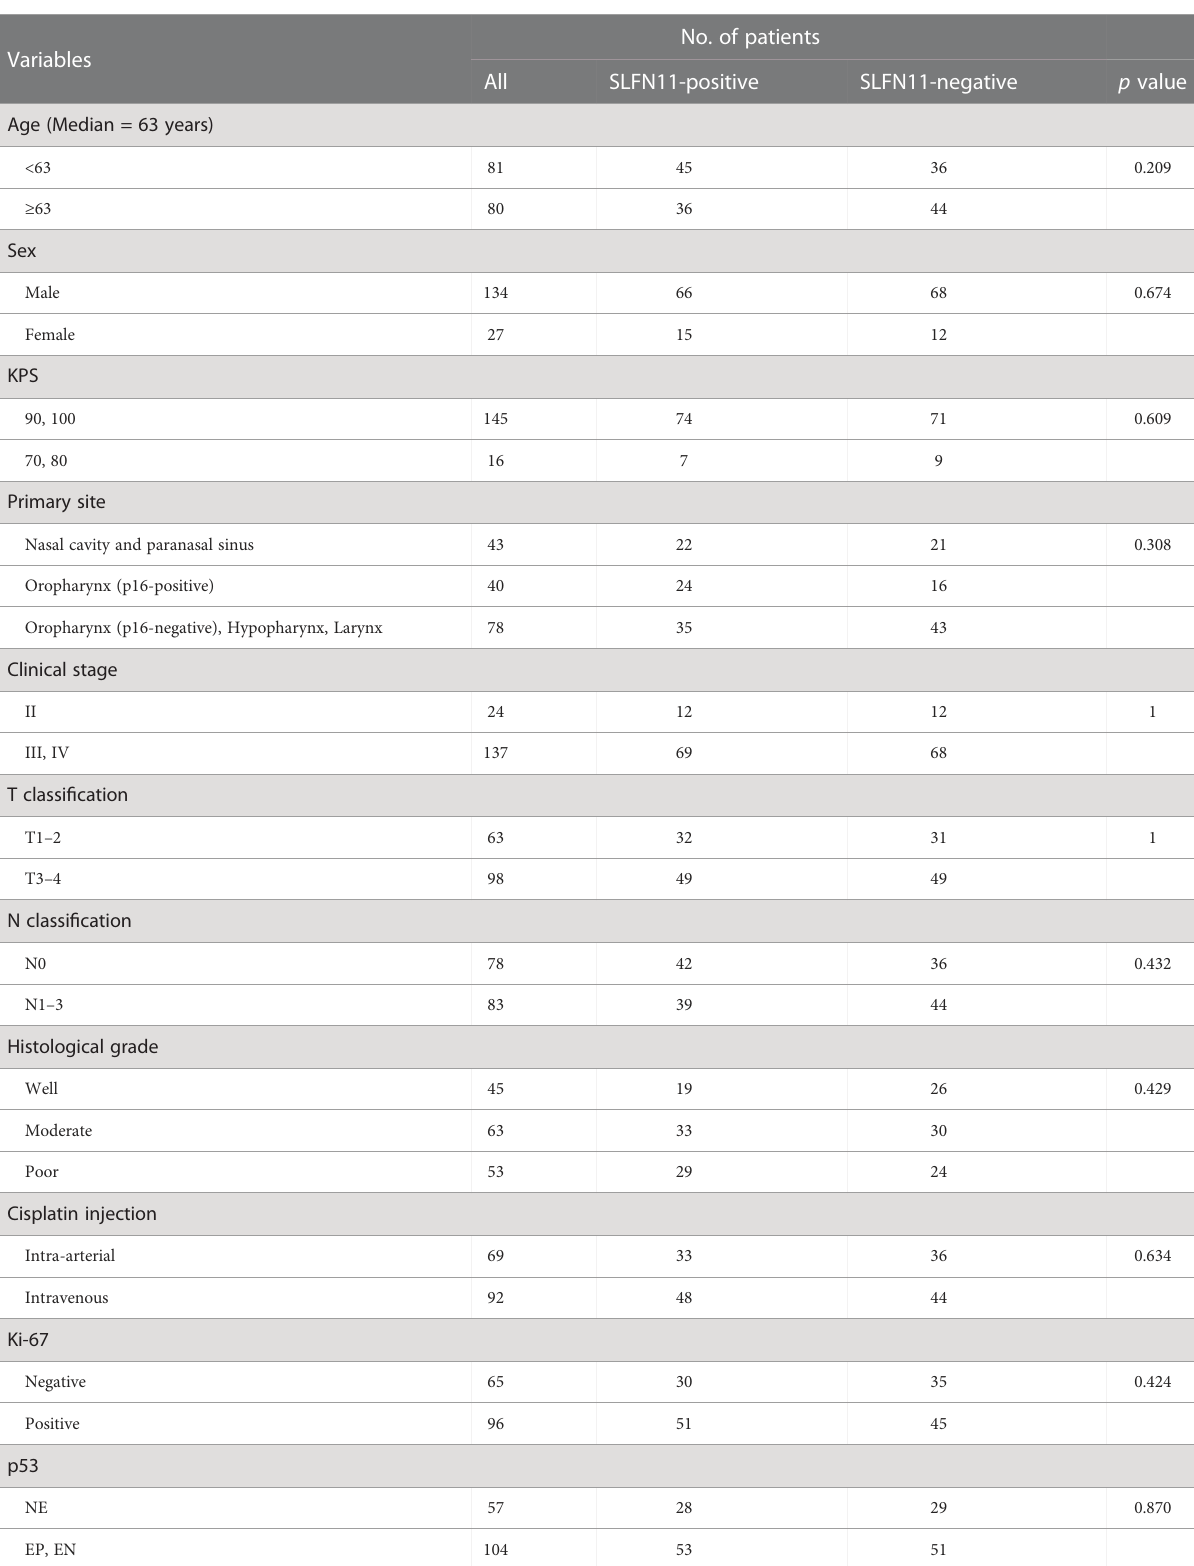
TABLE 1 Clinicopathological characteristics of patients according to SLFN11